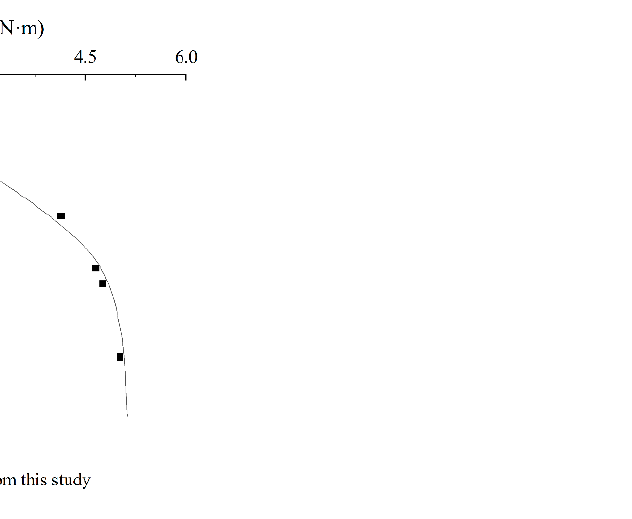
14 of 18 Figure 9. Comparison of Vertical force–new displacement curves at pile top and the experimental data of this study. 4.3. Calculation of Single Pile Bearing Capacity under V → T Loading Path To verify the bearing capacity of the pile under the V → T loading path, the experi-